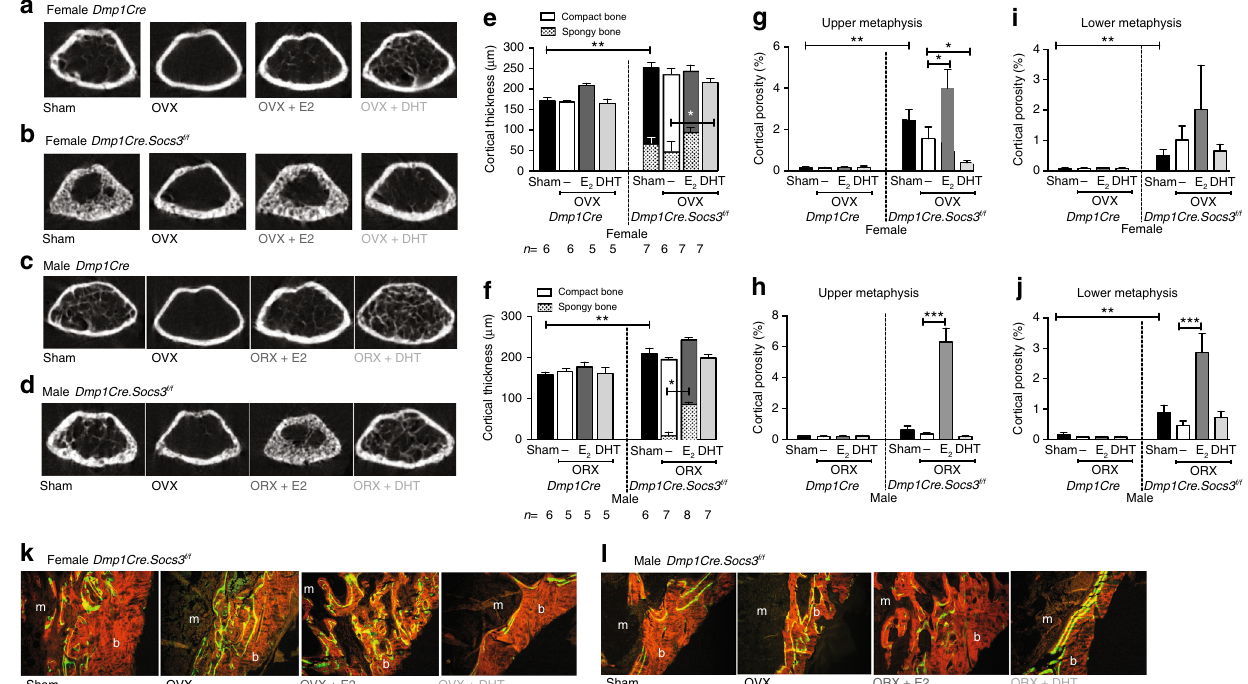
Fig. 6 Androgen treatment rescues the female Dmp1Cre.Socs3 f/f defect in corticalization, whereas estradiol treatment of male Dmp1Cre.Socs3 f/f mice recapitulates the female phenotype. Treatment protocol is shown in Fig. 5a. a , b , e , g , i , k Female mice. c , d , f , h , j Male mice. Shown are transaxial cross sections at the top of the femoral metaphyseal region of analysis in female ( a , b ) and male ( c , d ) Dmp1Cre ( a , c ), and Dmp1Cre.Socs3 f/f ( b , d ) mice sham- operated or gonadectomized (ovariectomy OVX, orchiectomy ORX) and treated with silastic implants of dihydrotestosterone (DHT) or estradiol (E2) from 6 – 12 weeks of age. Data shown are cortical thickness, including both compact cortical bone, and porous (spongy) bone, the latter shown in hatched bars ( e , f ), and cortical porosity measured at both the upper ( g , h ) and lower ( i , j ) metaphysis in female ( e , g , i ) and male ( f , h , j ) Dmp1Cre and Dmp1Cre.Socs3 f/f mice sham-operated or gonadectomized and treated with silastic implants of DHT or E 2 from 6 – 12 weeks of age. Values are mean + SEM, n is shown for each group in e , f ; * p < 0.05; ** p < 0.01 for comparisons indicated in the fi gure by two-way ANOVA with Sidak post-hoc test. k , l Representative histological images of calcein labels in the corticalization zone on the lateral side of the tibial metaphysis for each treatment group. Orange = bone; green = calcein; m = marrow; b =